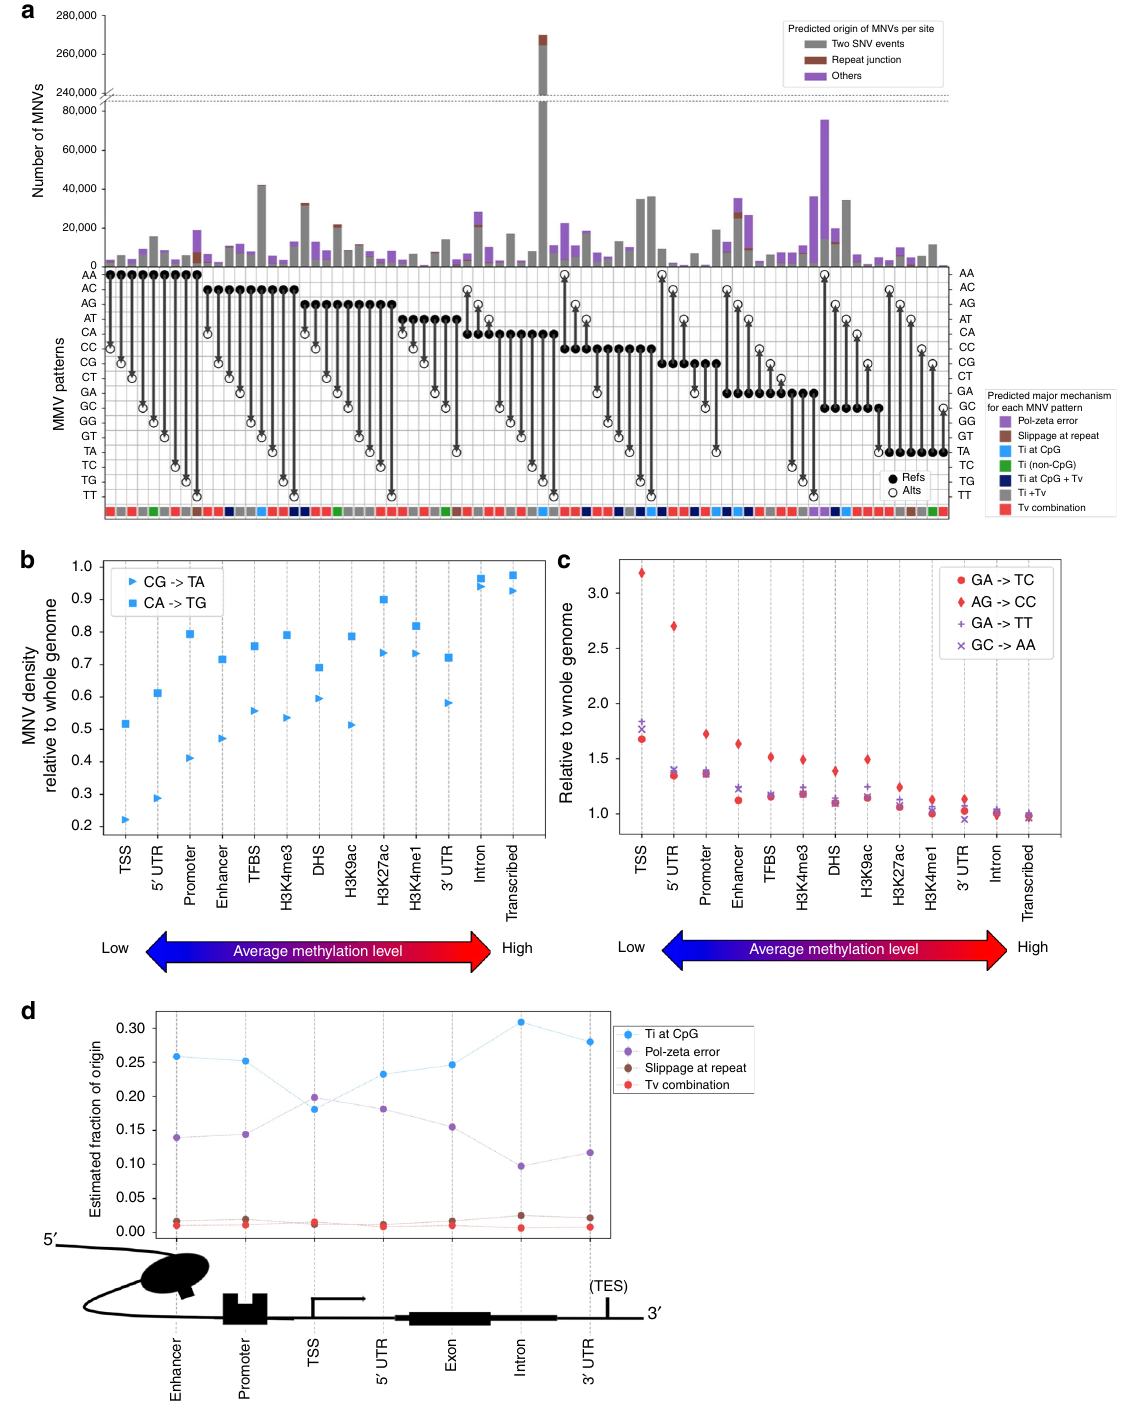
Fig. 4 Distribution of MNVs across genome. a The number and the fraction of MNVs per origin, per substitution pattern. Gray are the estimated fraction of MNV originating from two single-nucleotide substitution events, brown for polymerase slippage at repeat contexts and purple are the others (presumably mainly replication error by pol-zeta). The colors along the bottom represent the estimated biological origins that dominate MNVs of that speci fi c substitution pattern. b , c MNV density, de fi ned as the number of MNVs per functional annotation divided by the base pair length in the annotation (relative to the whole-genome region), ordered by the methylation level of the functional category. d Estimated fraction of MNVs by different origins, per functional category around the coding